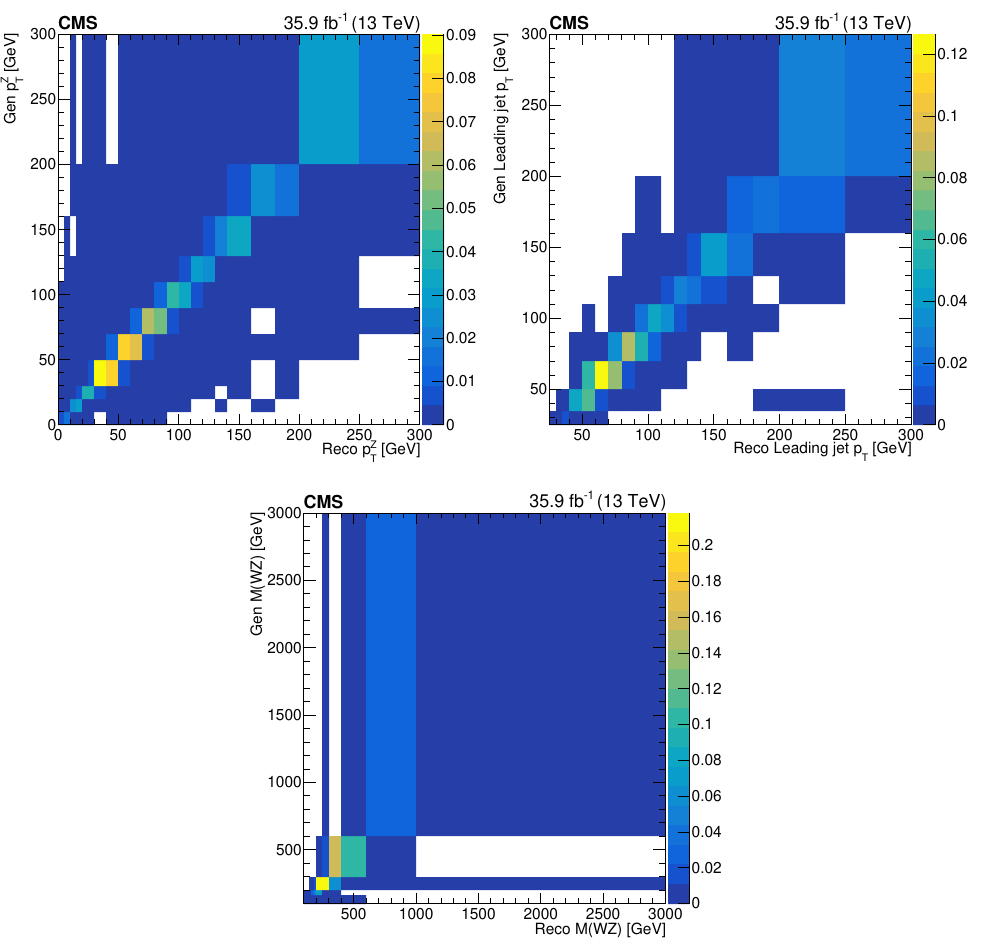
Figure 9 . Response matrices obtained using NLO samples, simulated with the powheg generator and normalized to unity. The transverse momentum of the Z boson (top left), the leading jet transverse momentum (top right) and the mass of the WZ system (bottom) are